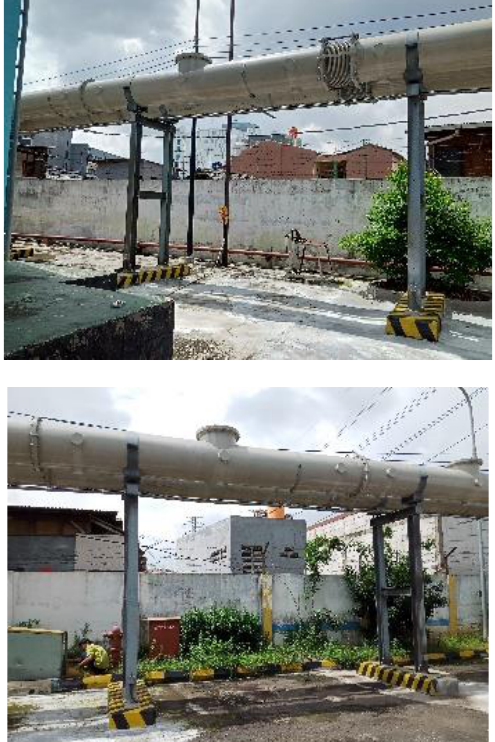
Figure 2. Photos taken in reconnaissance survey to build 3D model of site